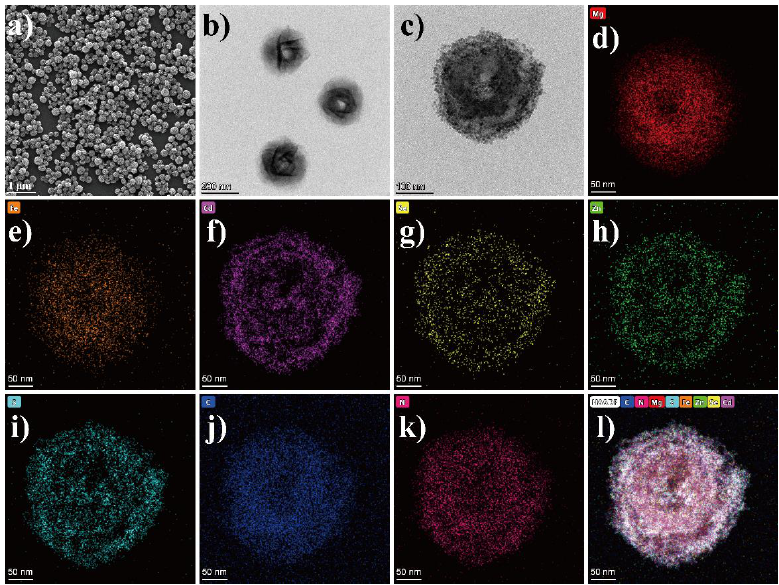
Figure 2. ( a , b ) Field emission scanning electron microscope (SEM) and transmission electron microscope (TEM) images of Mg/Fe LDH NFs. ( c ) TEM images of MF@CdSe/ZnS@PEI NFs. ( d – l ) EDS